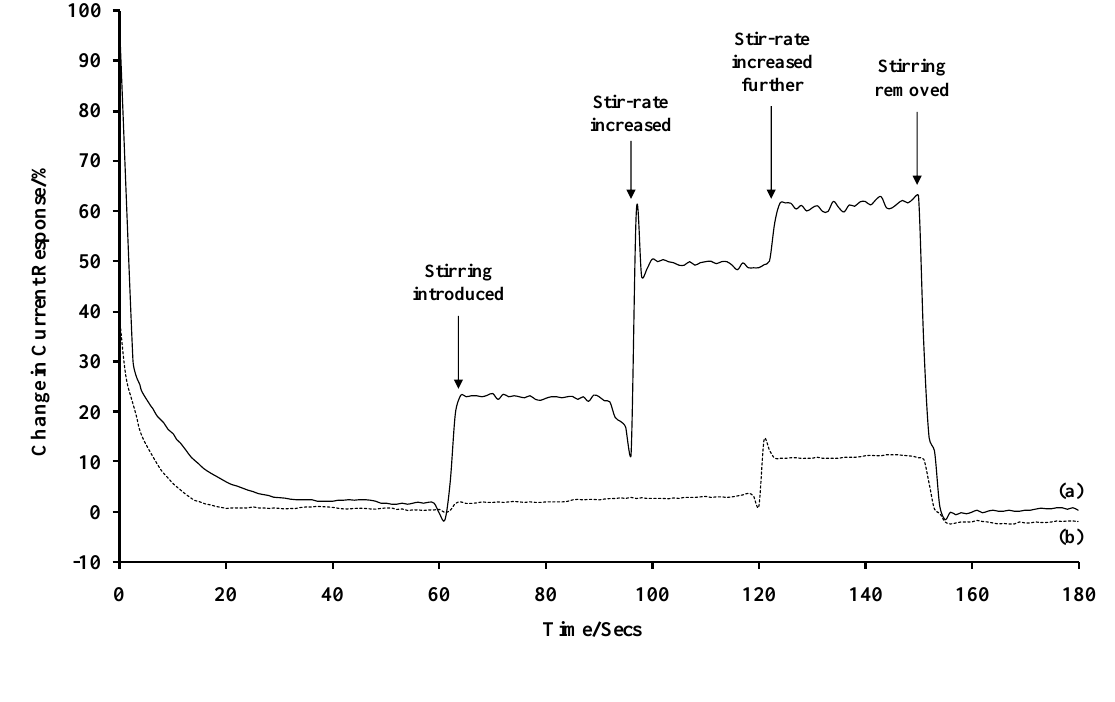
Figure 6. Stir-rate dependence in terms of percentage current change for (a) a bare carbon electrode and (b) a sonochemically fabricated microelectrode array (average response of 10 sensors), in 1 mM hexaammineruthenium(III) chloride. [Supporting electrolyte: phosphate buffer (0.1 M, pH 7.4). Polarising potential: –0.35 V ( versus